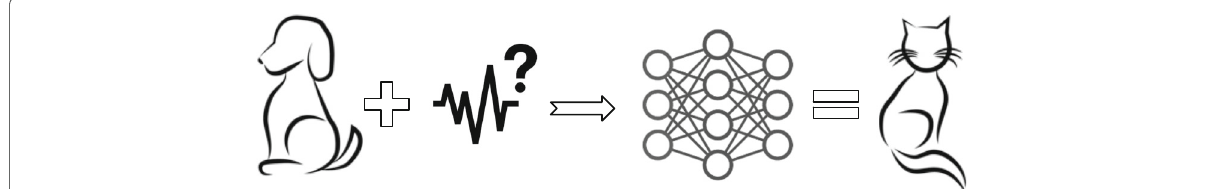
Fig. 2 Threat model for theoretical adversarial example